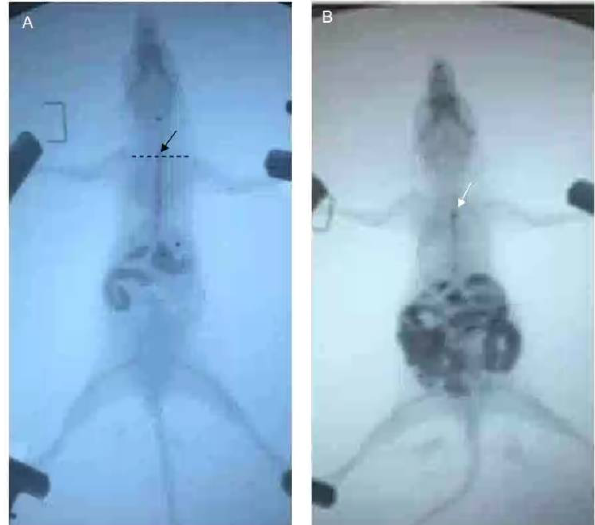
Figure 3. Esophageal emptying test in mouse. ( A ) Contour of the esophagus with 0.1 mL iohexol as contrast agent. The release position of the X-ray opaque marker was at the level of sternum angle shown with black arrow. ( B ) The movement of the X-ray opaque marker through esophagus. White arrow refers to the marker.